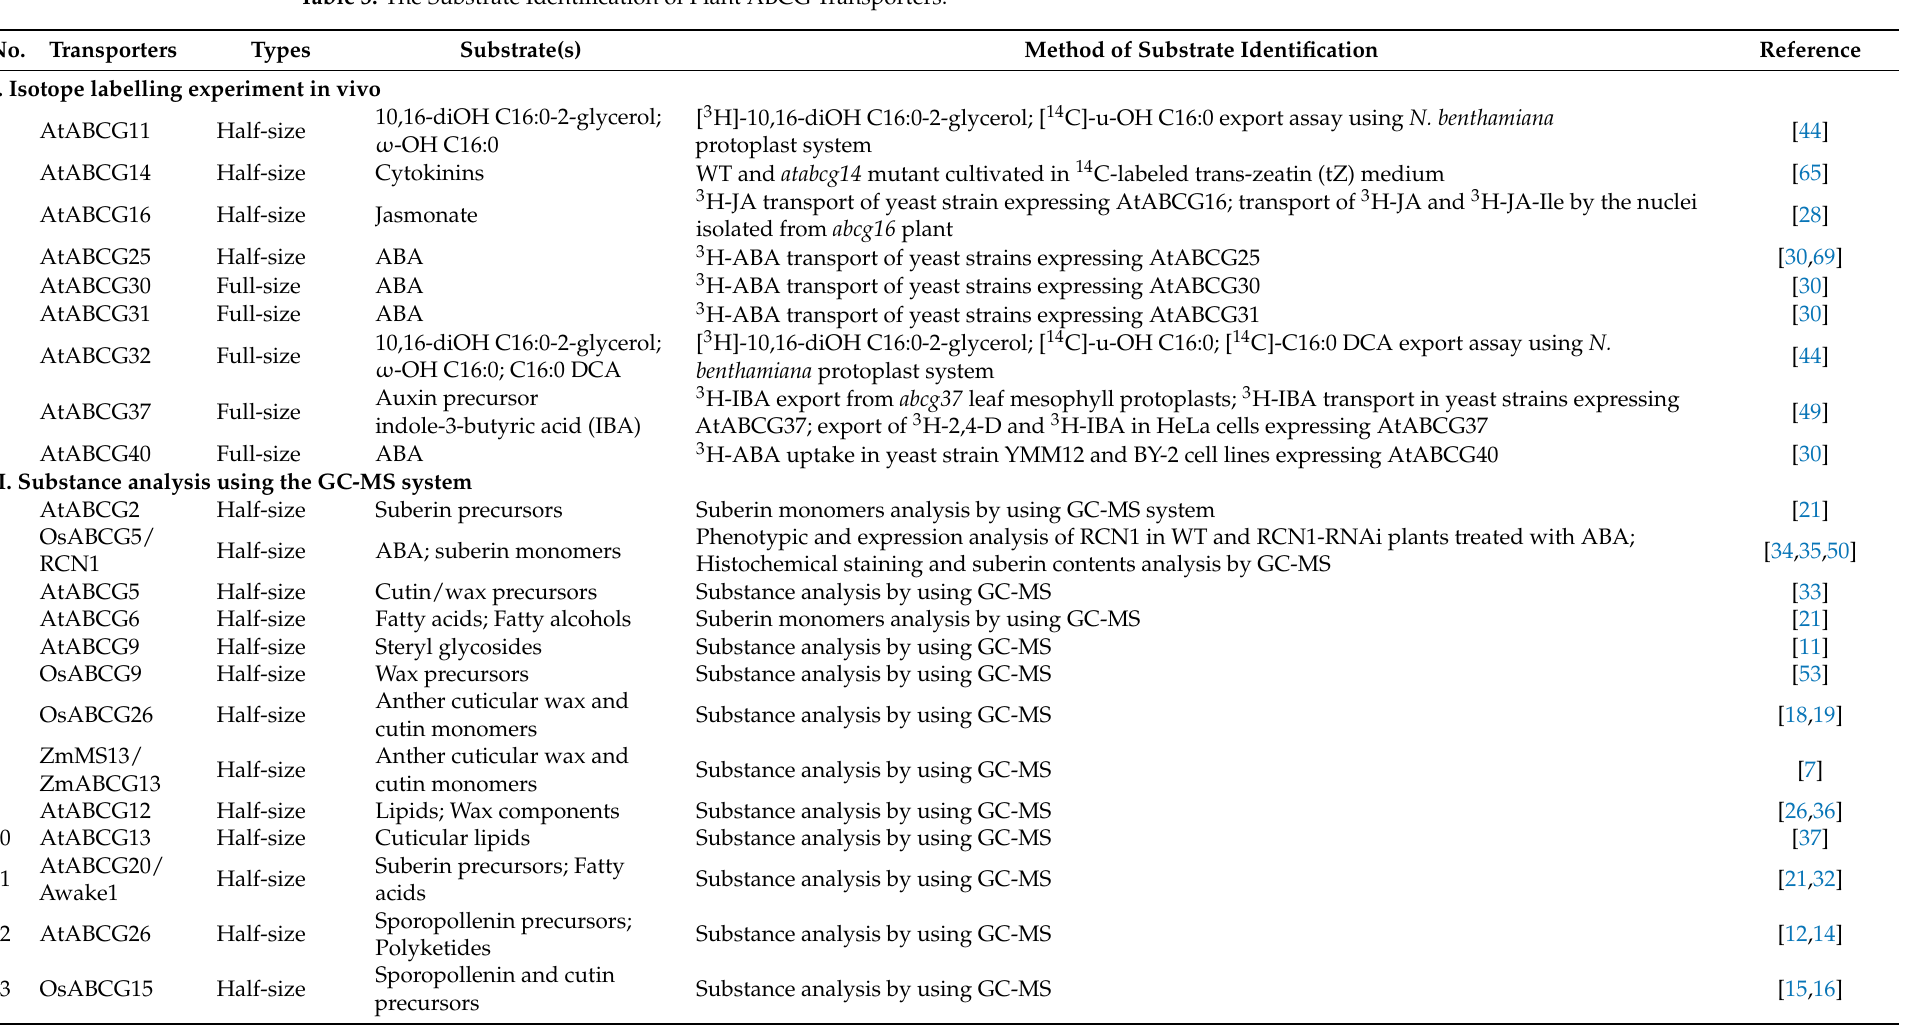
Table 3. The Substrate Identification of Plant ABCG